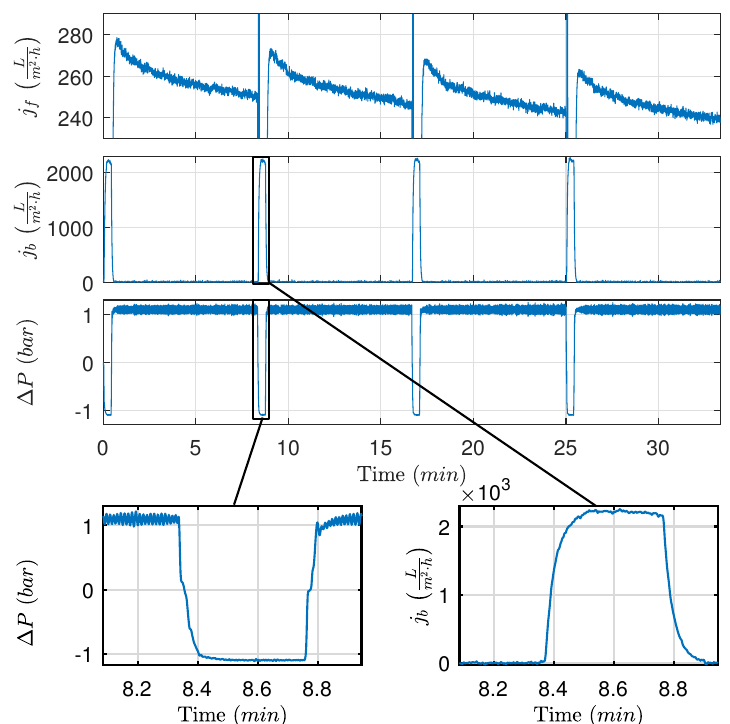
Figure 7. Experiment showing much higher backwashing flow compared to permeate flow at identical pressure. Experimental conditions: t f = 475 s, t b = 25 s, Q cf , ref = 1 m − 1.1 bar.